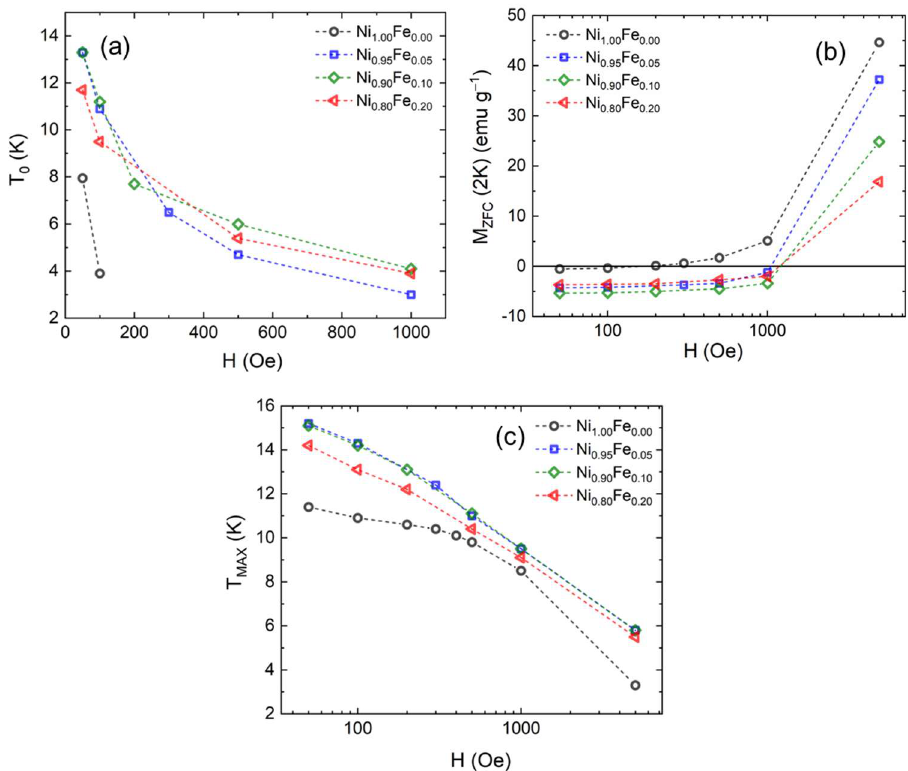
Figure 8. ( a ) Compensation point, T 0, as a function of the applied magnetic field, and ( b ) ZFC magnetization at 2 K versus applied magnetic field, and ( c ) temperature at which the ZFC magnetization has a maximum T MAX , versus applied magnetic field, for Ni 1.00 Fe 0.00 (0% Fe), Ni 0.95 Fe 0.05 (5% Fe), Ni 0.90 Fe 0.10 (10% Fe), and Ni 0.80 Fe 0.20 (20% Fe). The ZFC magnetization at 2K is plotted on Figure 8b as a function of the applied magnetic field. The ZFC Magnetization is negative for all samples for the 50 Oe and 100 Oe applied magnetic fields. The M ZFC for the 0% Fe sample that shows ferromagnetic be- havior has the smallest magnitude which is very close to zero. In contrast, the value of M ZFC for the 5, 10 and 20% Fe samples has a larger magnitude and remains negative for up to a 1000 Oe applied magnetic field. Note that the magnitude of M ZFC does not increase as a function of the magnetic field; rather, it is flat and increases sharply when a 5000 Oe magnetic field is applied which points to an intrinsic origin and not external factors such as a demagnetizing field. In our case, the negative magnetization can be understood as magnetic moments being pinned by magnetocrystalline anisotropy due to the multiple crystallographic domains. The pinning energy is higher than the energy imparted by the external magnetic field of 1000 Oe for the samples doped with Fe. Additionally, the M ZFC at 5000 Oe is largest for the 0% Fe sample and decreases monotonically with Fe %, which